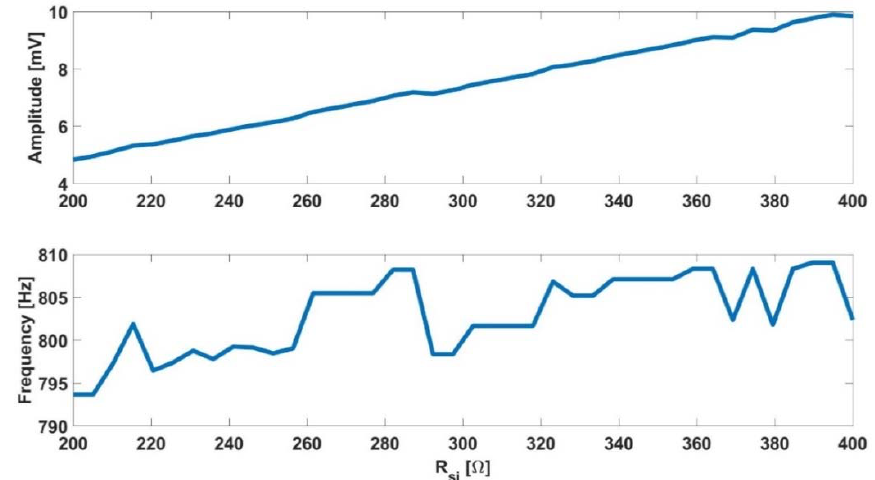
Figure A3. Variation of initial oscillation amplitude and frequency as a function of R s value.